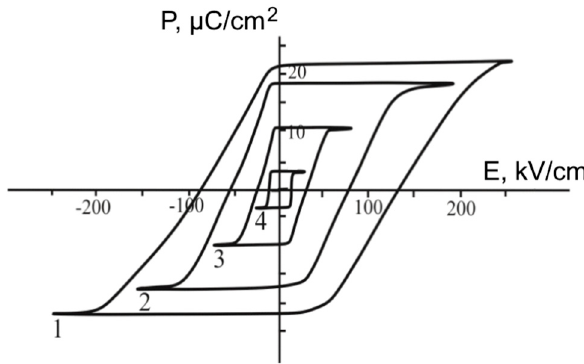
Figure 5. Dielectric hysteresis loops for BaZrO 3 /BaTiO 3 superlattices at the different temperatures: Curves 1, 2, 3, and 4 correspond to 20 ° С , 340 ° С , 380 ° С , and 395 ° С , respectively.